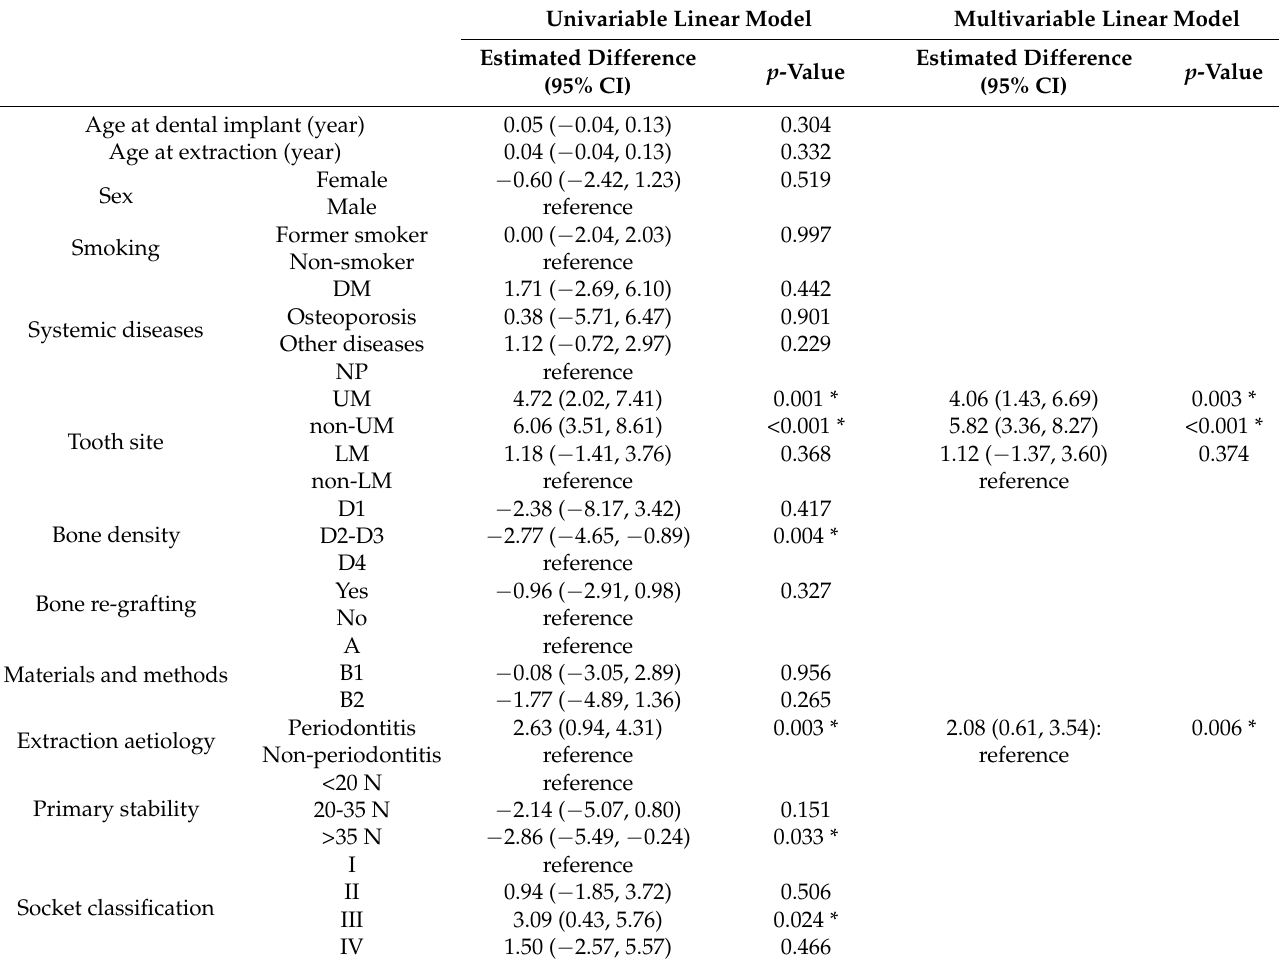
Table 5. The independent factors influencing total treatment